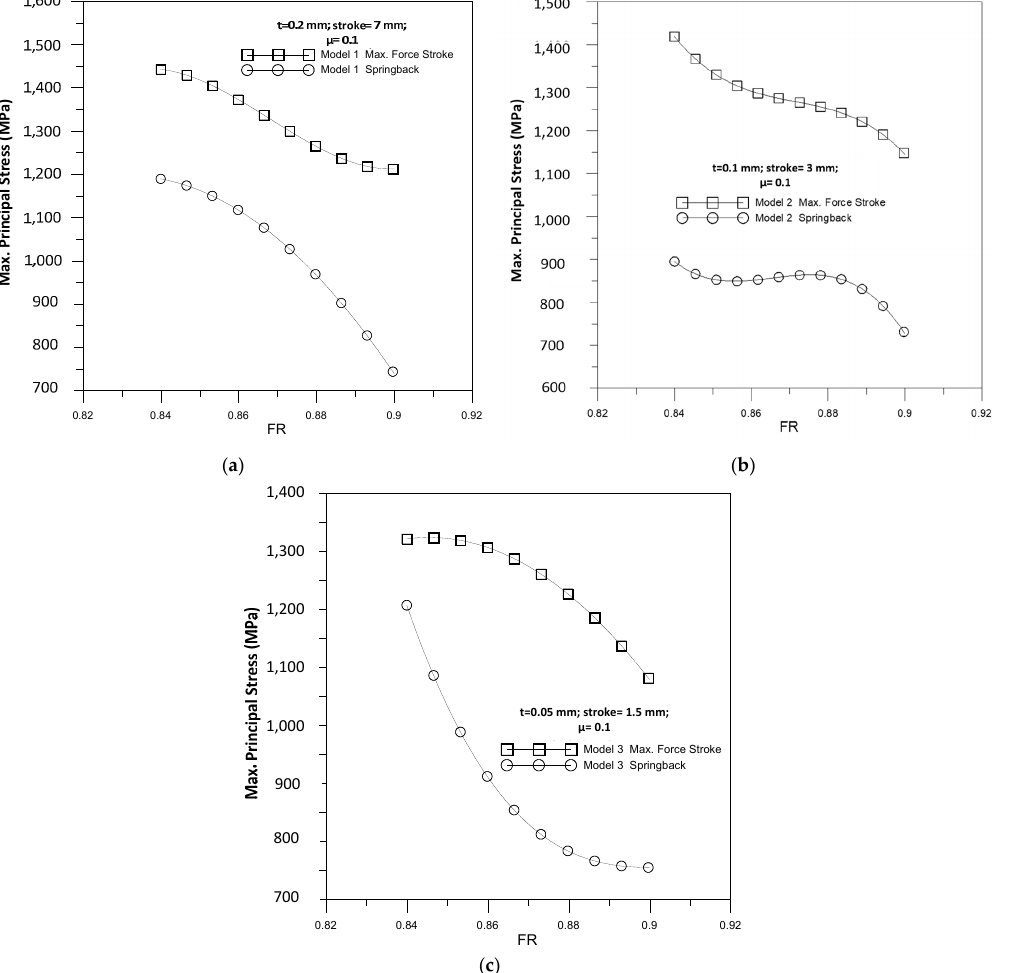
Figure 15. The relationship between the forming ratio and maximum principal stress in the flange: ( a ) Model 1; ( b ) Model 2; ( c ) Model 3.